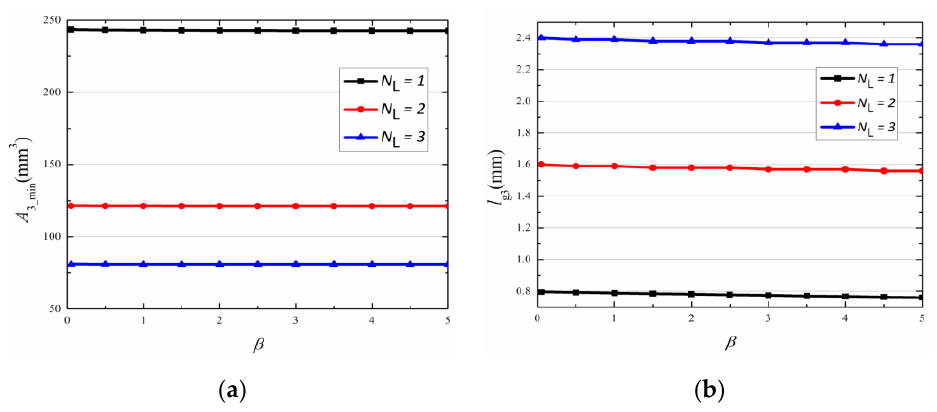
Figure 10. ( a ) Curve of A 3 in relation to N L and β ( b ) Curve of l g in relation to N L and β . For the design of the effective cross-sectional area of each leg, two factors should be considered: preventing saturation and hysteresis loss in the ferrite core. Let the subscript y , ranging from 1 to 5, denote the leg; the minimum cross-sectional area required to prevent ferrite core saturation is obtained using Equation (29).